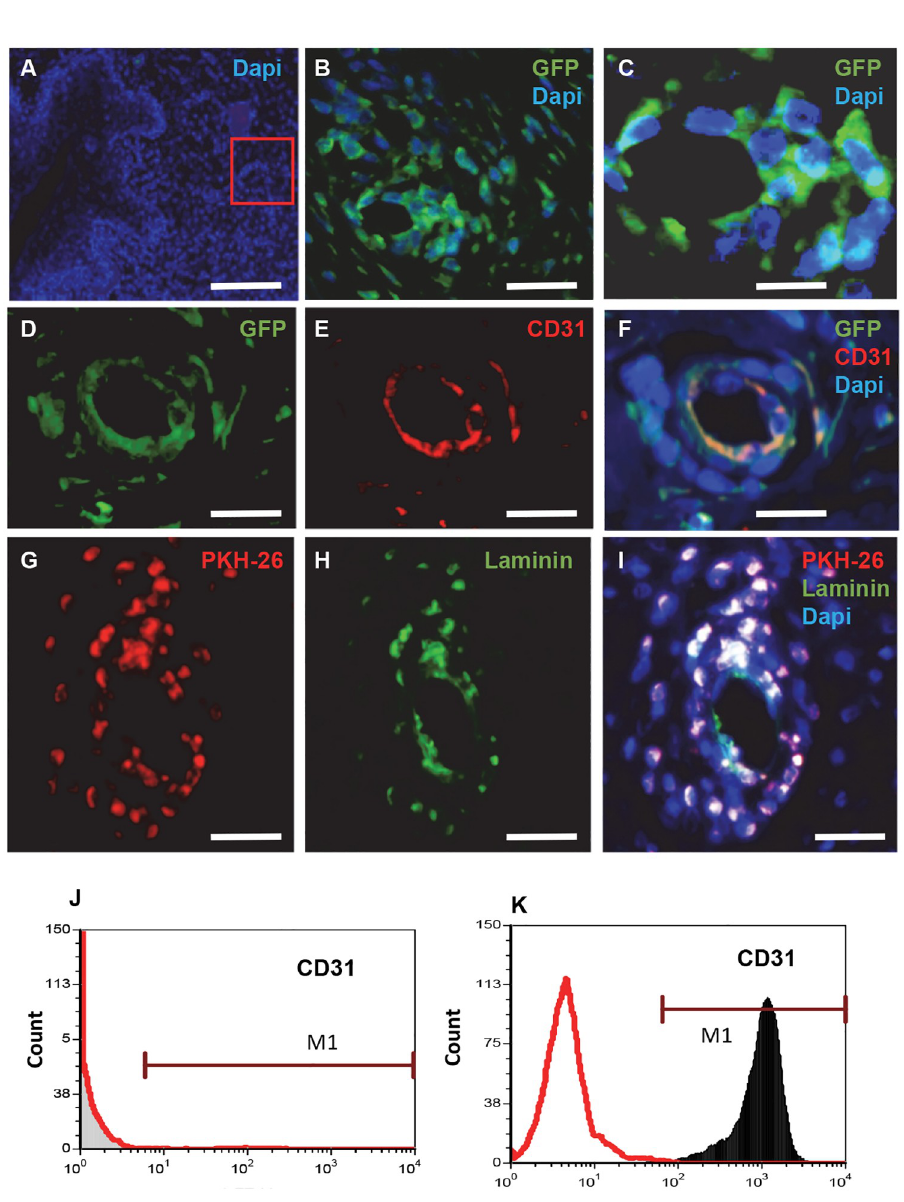
Fluorescence image of this capillary-like structure shows that it mostly made of GFP-expressing cells (B). A higher magnification of B is demonstrated in (C). Sections were stained with anti- GFP (D) and the endothelial marker CD31 (E). The co-localization of CD31 and GFP is shown in (F). PKH-26 transplanted cells (G), expressed laminin (H) and the co-localization of PKH-26 and laminin is shown in (I). FACS analysis prior to transplantation showed that